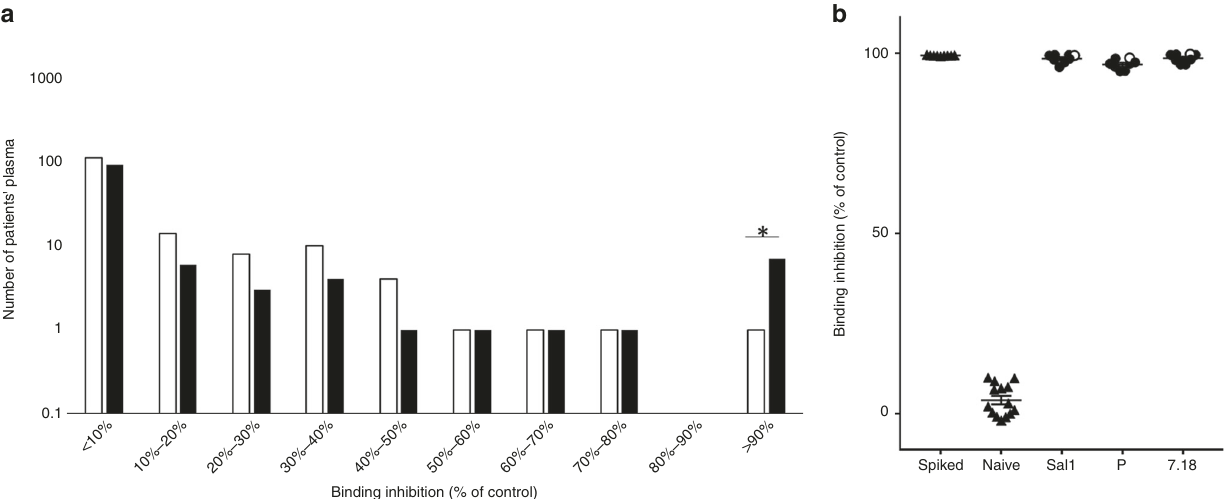
Fig. 5 Most Pv parasites infecting individuals displaying antibodies highly inhibiting the PvDBP-red blood cell binding have multiple copies of pvdbp . a Distribution of parasites with single pvdbp copy ( n = 151, open bars) or multiple copies ( n = 116, plain bars) across patients with binding inhibitory antibodies ranging from < 10% inhibition to > 90%. Individual plasma (at 1:5 dilution) are tested for their capacity to inhibit the binding of rDBPII (Sal1 allele) to red blood cells. The proportion of pvdbp -ampli fi ed isolates compared to single copy ones is signi fi cantly different only for patients displaying more than 90% binding inhibitory activity (7/116 and 1/151 respectively, Fisher ’ s exact test, P = 0.023). b Binding inhibitory antibodies from infected patients are strain transcending. The plasma (at 1:5 dilution) from all eight patients (plain circles infected with multiple pvdbp copies parasites and open circles with single copy) show >90% binding inhibition to three different DBPII alleles (Sal1, P and 7.18) similarly to plasma from malaria naïve individuals spiked with the humab 092096. Naïve plasma display <10% binding inhibition. Source data are provided as a Source Data fi